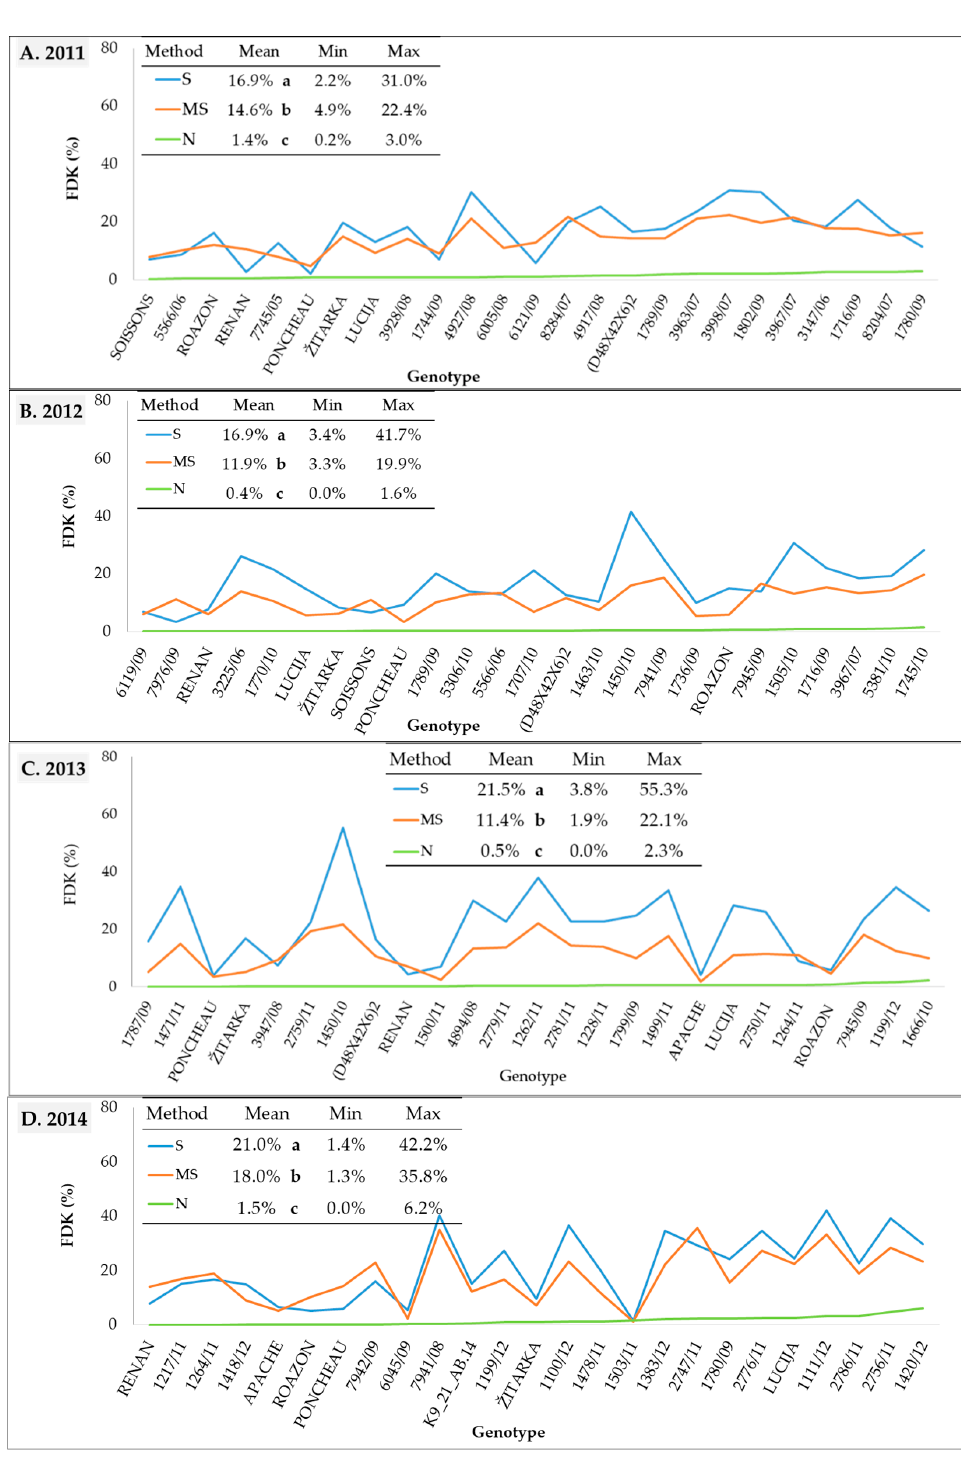
Figure 3. Fusarium-damaged kernels (FDK) in 25 wheat genotypes under spray inoculation (S), maize stalk inoculation (MS), and natural infection (N) in the ( A ) 2011, ( B ) 2012, ( C ) 2013, and ( D ) 2014 growing seasons. Means of the inoculation methods followed by the different letter are significantly different according to LSD test at p < 0.05.